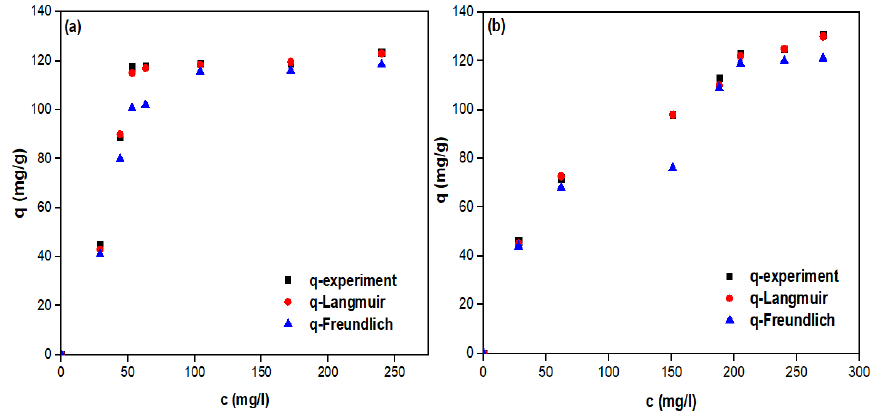
Figure 7. Experimental vs Langmuir and Freundlich isotherms ( a ) SO 2 ( b ) NOx. Reproduced with permission from Silas et al. [3]. Copyright 2018 Elsevier Ltd.